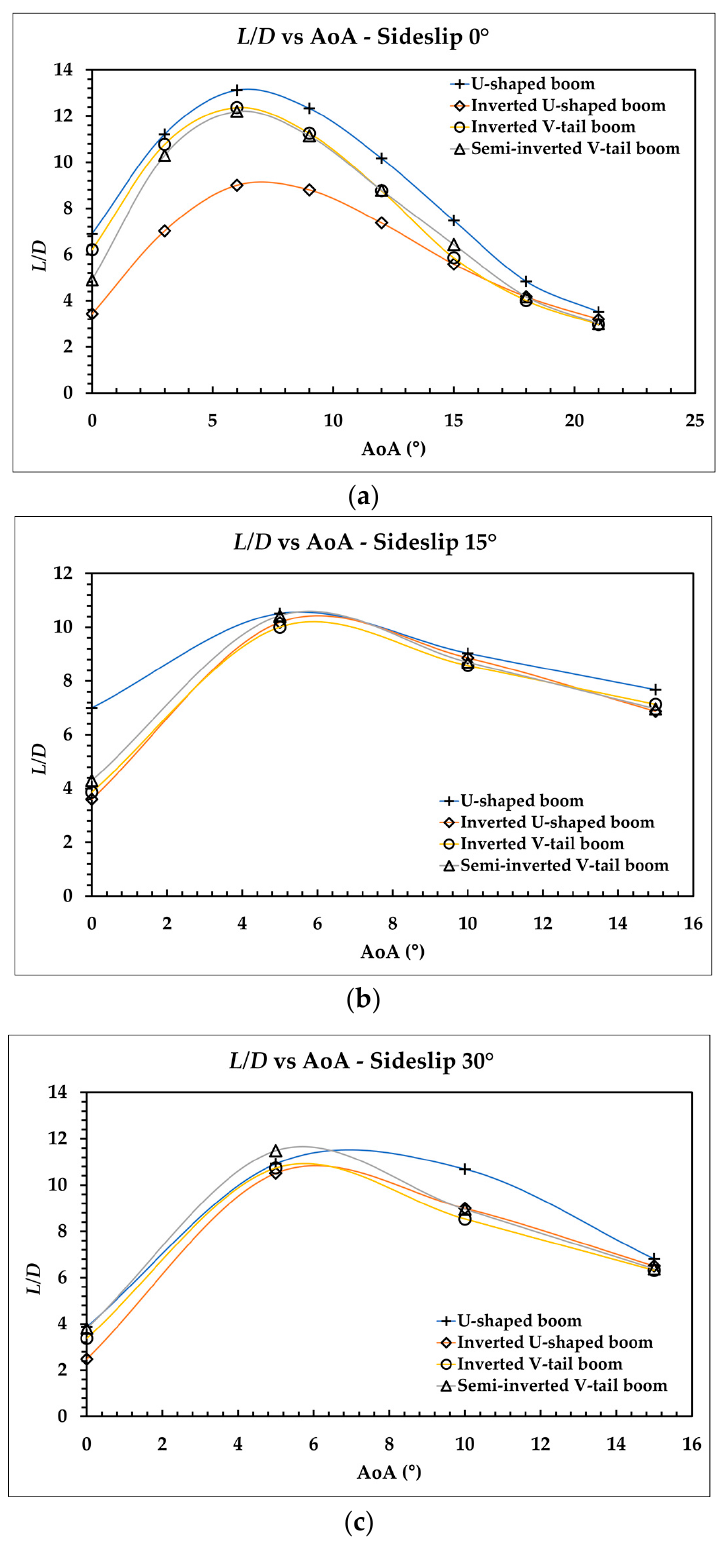
Figure 12. L/D vs. AoA, sideslip angle: ( a ) 0°, ( b ) 15°, and ( c ) 30°.